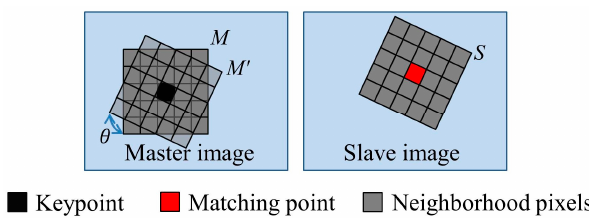
Figure 5. Schematic diagram for the reference chip rotation. M is the reference chip. M ʹ is the rotated chip. S is the match chip. The red pixel in the slave image is the matching point which corresponds to the keypoint in the master image.